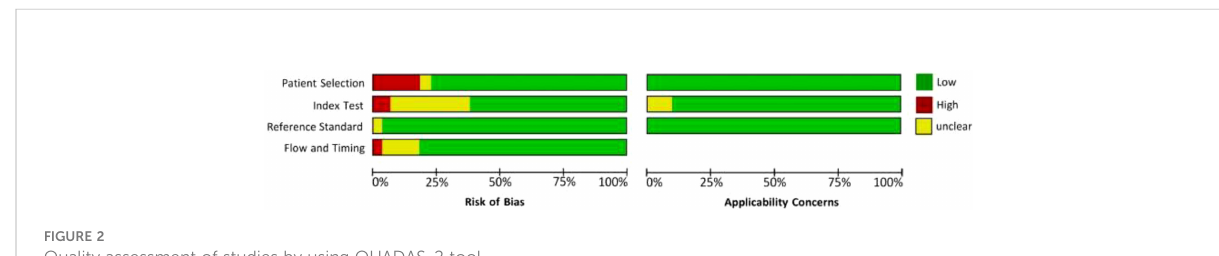
FIGURE 2 Quality assessment of studies by using QUADAS-2